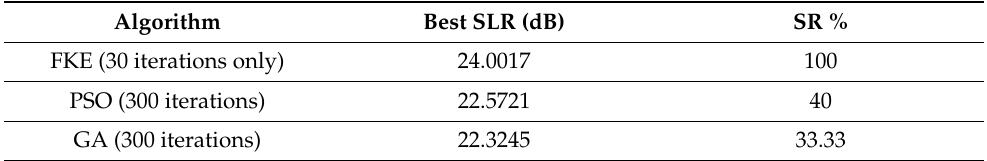
Table 3. The success rate (SR) of the proposed FKE algorithm, PSO, and GA for the sidelobe reduction using the inter-element spacing (No. of runs =